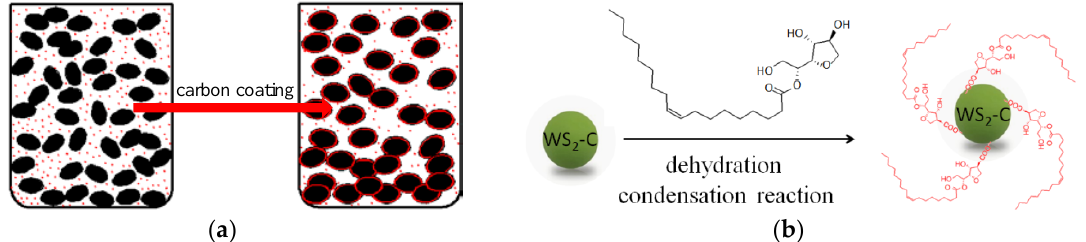
Figure 7. Schematic diagram of surface chemical modification: ( a ) carbon coating; ( b ) surface modification.